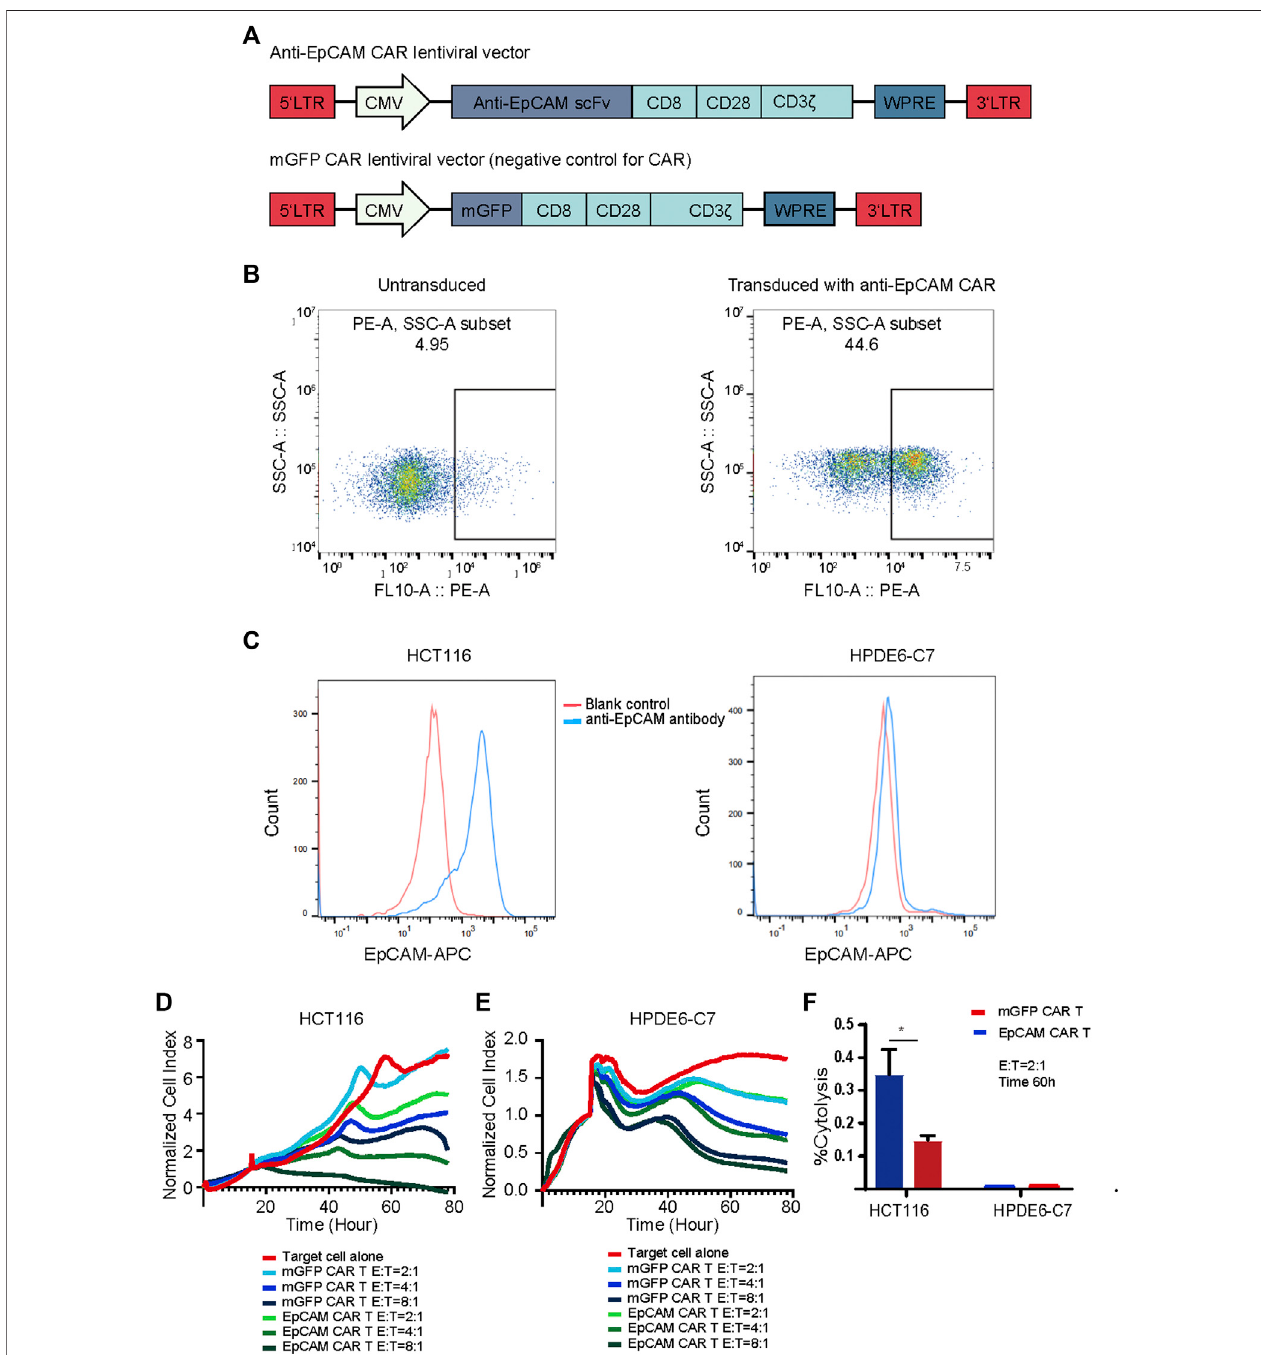
FIGURE 3 | Generation and validation of EpCAM CAR T cells. (A) Schematics of lentiviral vectors used in the study. (B) Flow cytometric analysis of the surface expressionofanti-EpCAMCARonthemodi fi edTcellsusingrecombinantbiotinylatedproteinLtobindtoscFvafter48 hoftransduction. (C) Flowcytometricanalysisof the surface expression of EpCAM on HCT116 and HPDE6-C7 using APC conjugated anti-human CD326 (EpCAM) antibody. The red line indicates the blank control while the blue line indicates the cells stained with anti-EpCAM antibody (D) RTCA application of EpCAM CAR T cells against EpCAM-high expressed HCT116 cancer cells. As target adherent cancer cells, HCT116 cells were seeded at a density of 5000 cells/well in a 16- well E-Plate and then moved to the incubator until they reachedalogarithmicgrowthphase.mGFP-CART,EpCAMCARTcellswereaddedintotheplateatE:Tratioof8:1,4:1and2:1,induplicate,andtheproliferationofthe HCT116 cells was continuously monitored, re fl ected by cell index values (CI). Y-axis is the normalized cell index produced by the RTCA software (samples have been internally normalized for the Cell Index value measured before T cells addition) and X-axis is the time of cell culture and treatment time in hour; (E) RTCA application of EpCAM CAR T cells against EpCAM-low expressed HPDE6-C7 normal cells; (F) %Cytolysis calculated based on the analysis of RTCA of (D) and (E) , at 60 h and E:T ratio of 2:1. Each experiment was performed in duplicate at least.